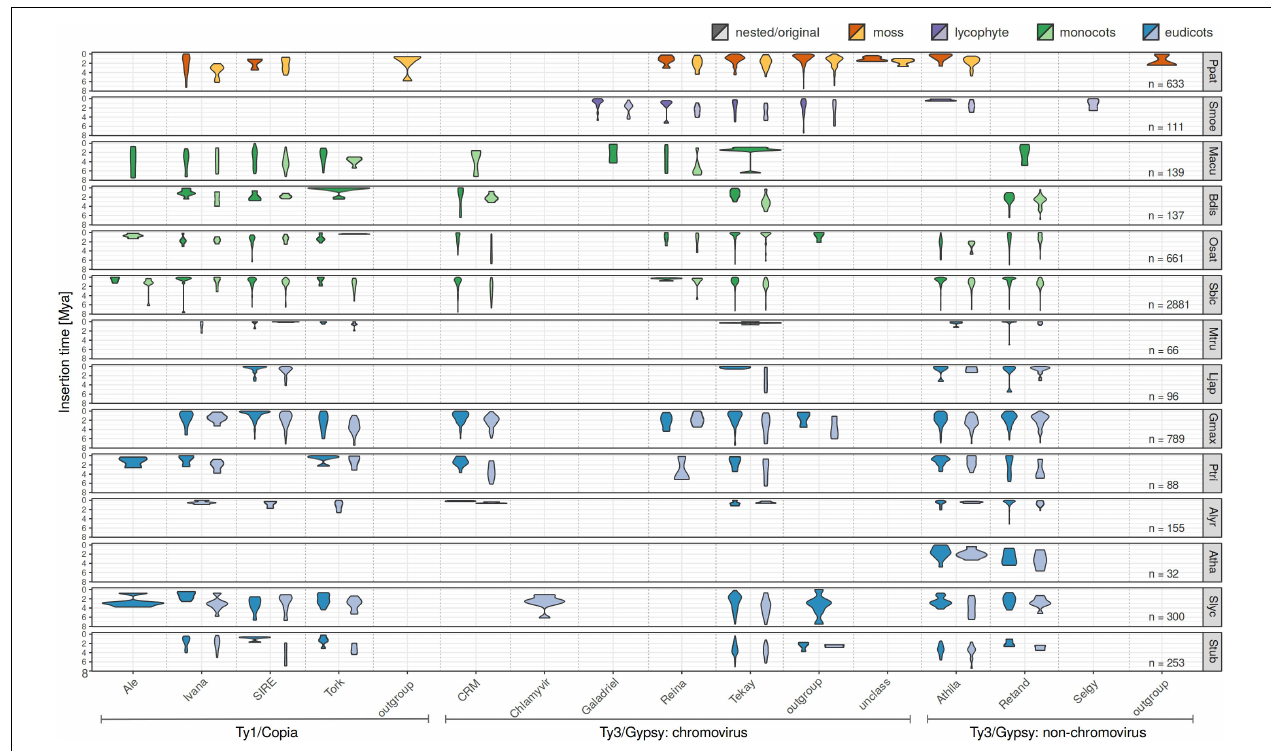
FIGURE 2 | Evolutionary dynamics of nested and original LTR retrotransposons of studied plant species using complex approach for LTR retrotransposon age estimation. For each species and each family, we measured the abundance of elements having specific LTR divergence to reveal evolutionary expansions and contractions occurring within each family. Nested (dark colors), original (light colors) LTR retrotransposons were analyzed separately. Low abundant families were excluded from this